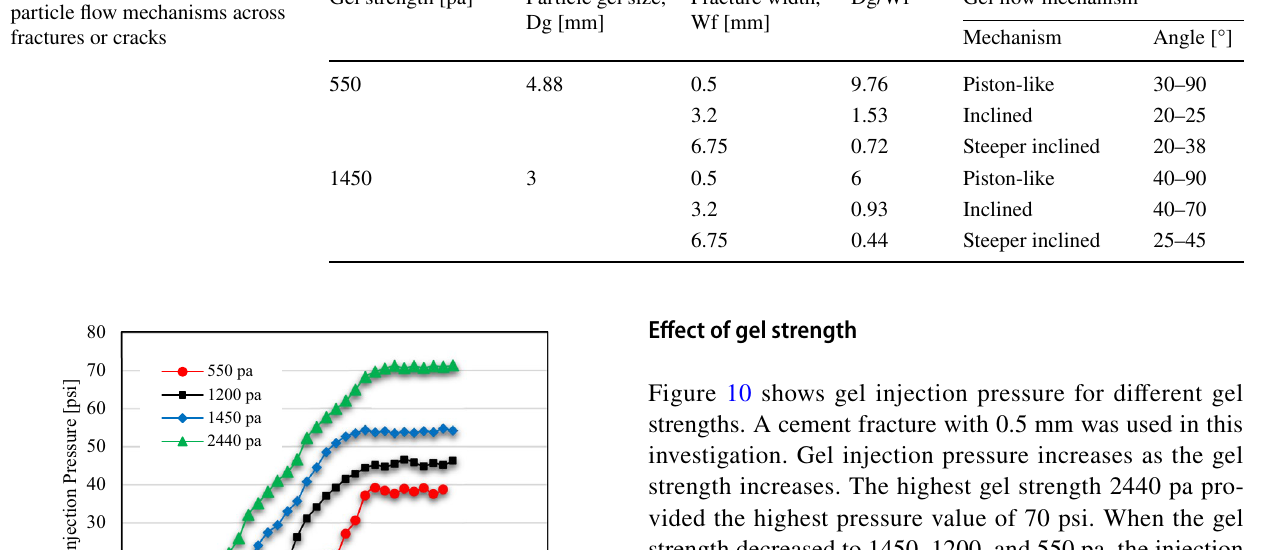
Table 3 A summary of the gel particle flow mechanisms across fractures or cracks